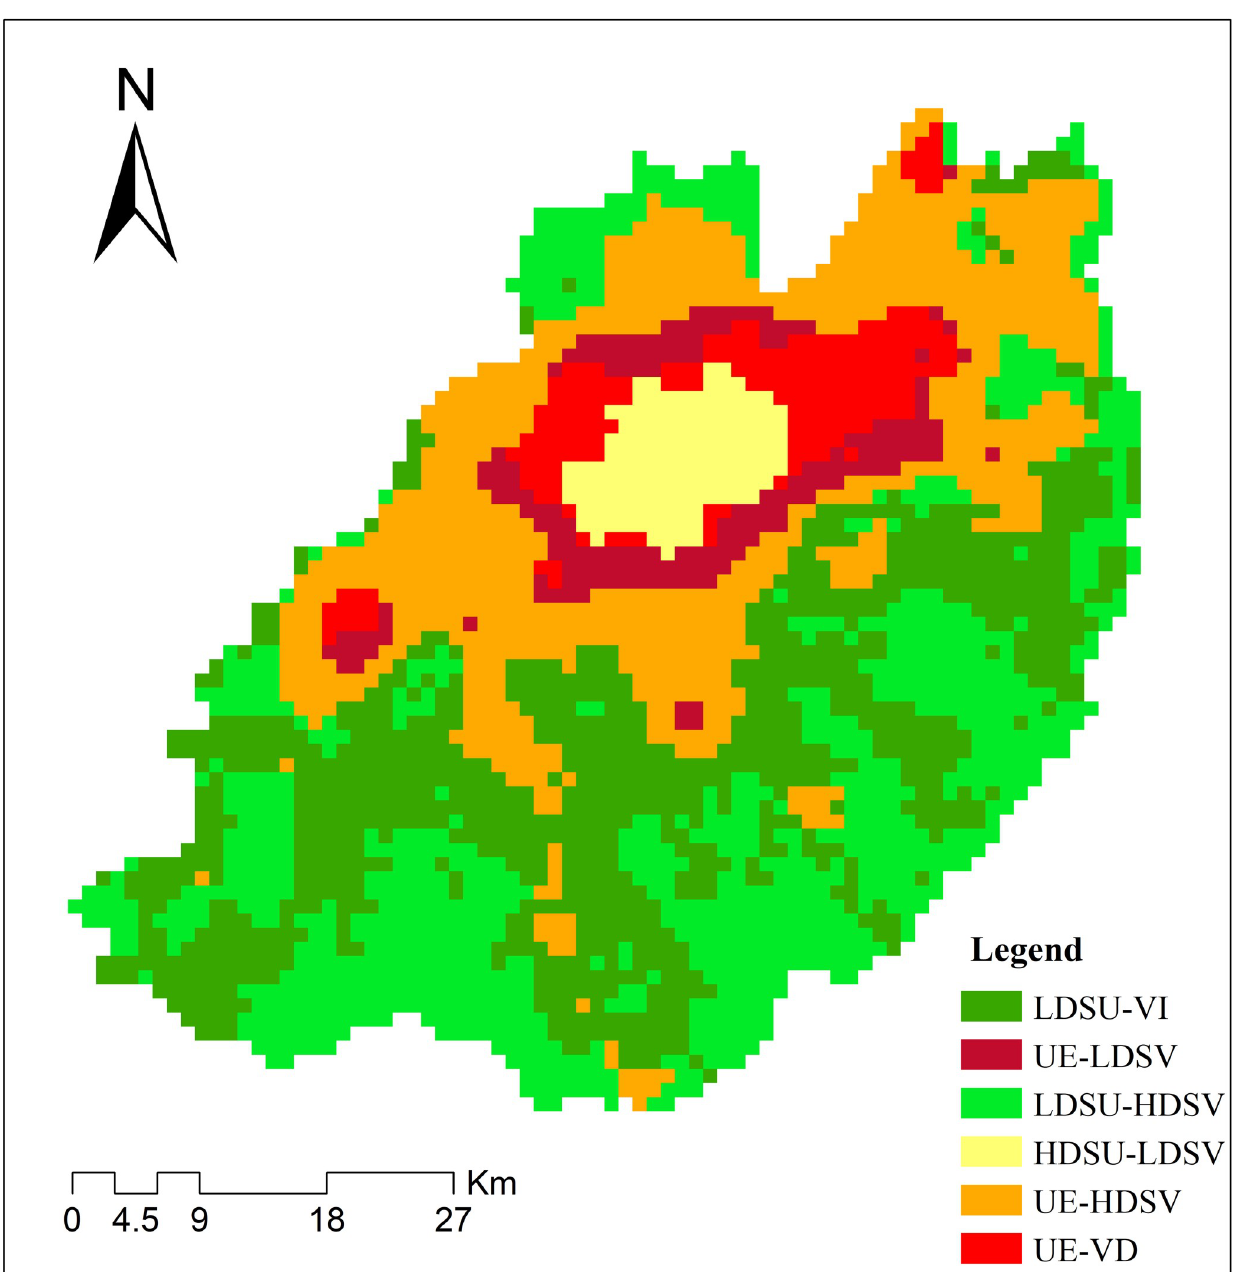
Fig 8. The urban development trend clustering results. LDSU-VI (type 1): Low density stable urban and vegetation increase type; UE-LDSV (type 2): Urban expansion and Low density stable vegetation type; LDSU-HDSV (type 3): Low density stable urban and High density stable vegetation type; HDSU-LDSV (type 4): High density stable urban and low density stable vegetation type; UE-HDSV (type 5): Urban expansion and high density stable vegetation type; UE-VD (type 6): Urban expansion and vegetation degeneration type.